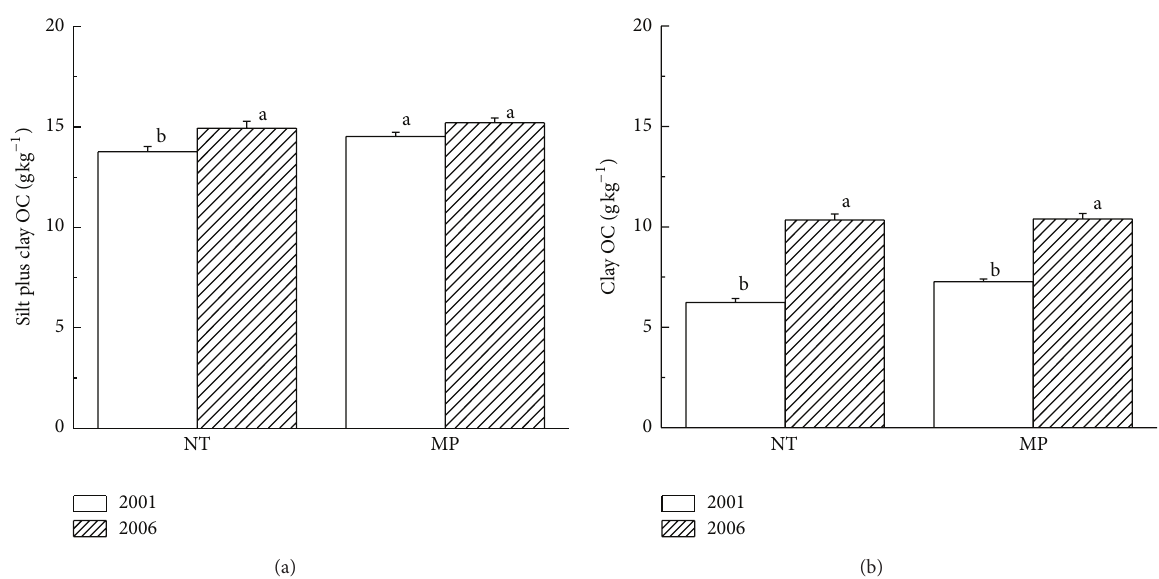
Figure 2: Soil organic carbon in < 20 𝜇 m particles of the 0–20cm layer under tillage